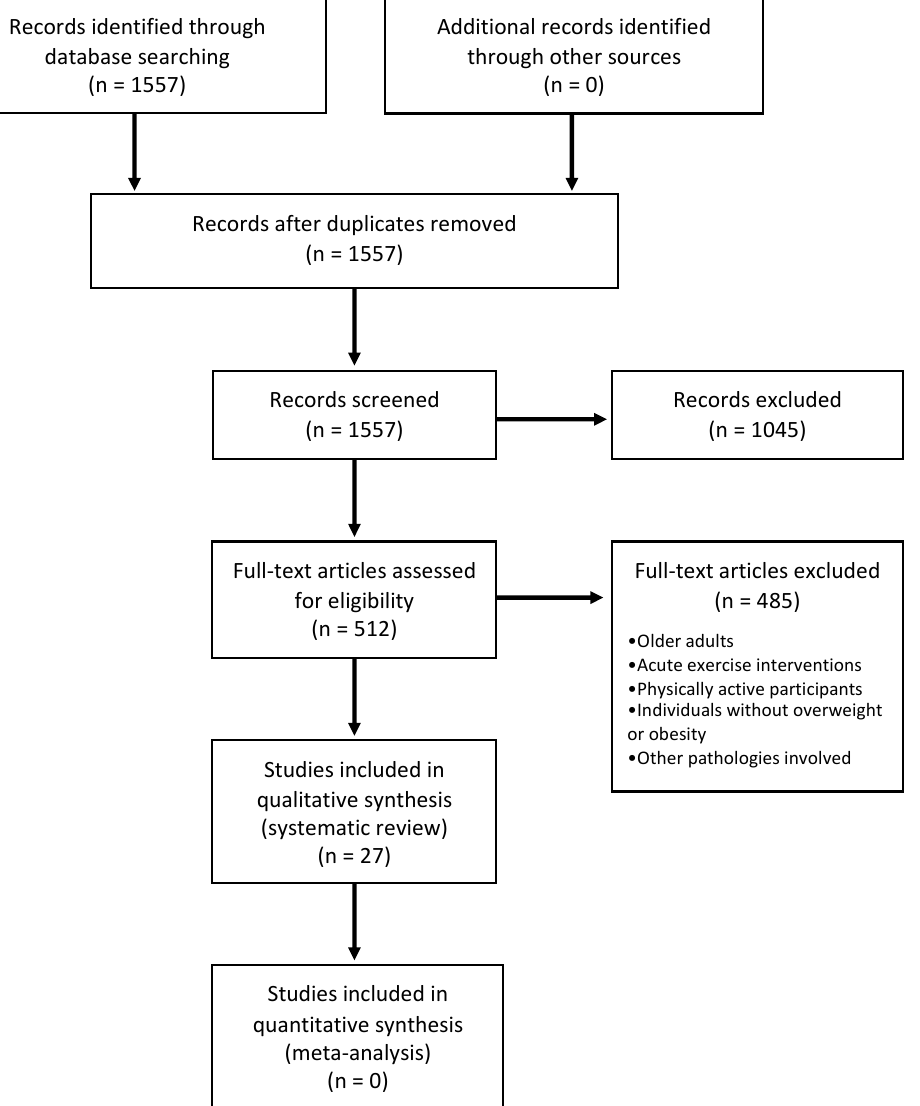
Figure 1. Flow diagram of the systematic review.